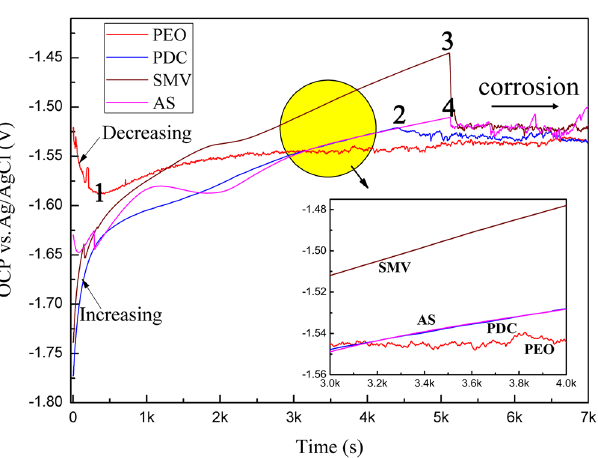
Figure 4. Variation of OCP with immersion time in 3.5 wt% NaCl solution after impregnation of